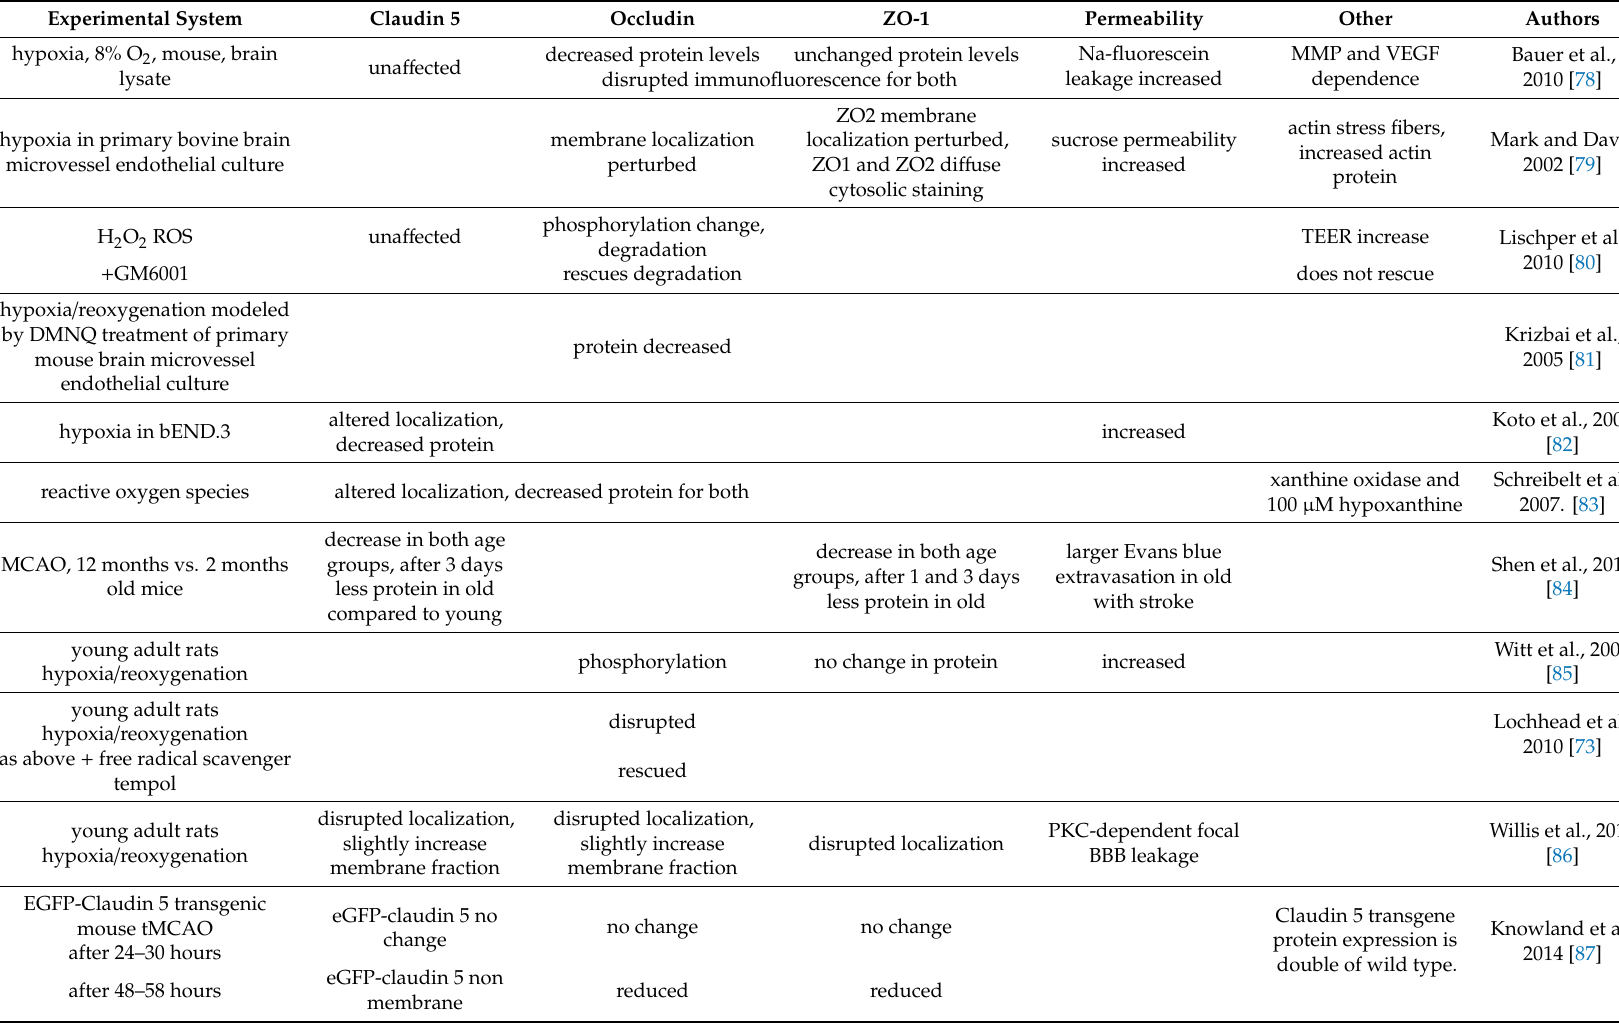
Table 2. BBB function and junctional proteins in age related disorders, ischemic injury and immune